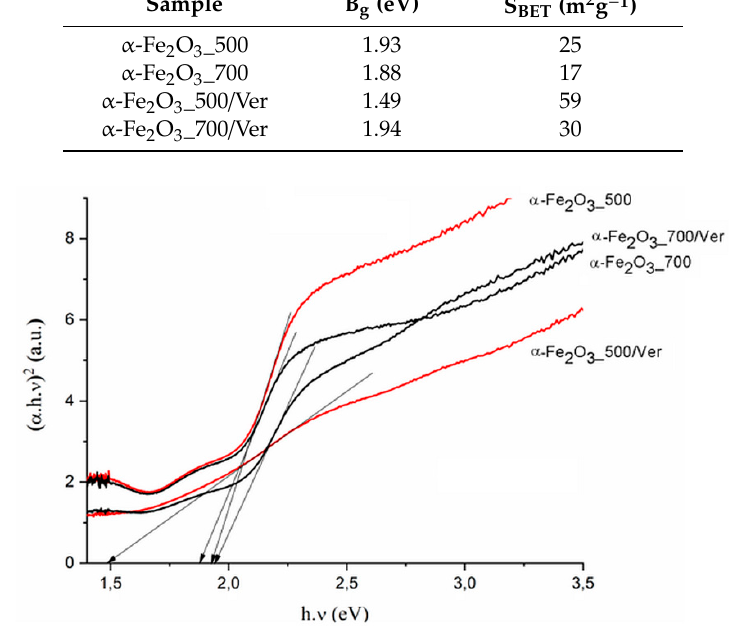
Table 3. Band gap energies (B g ) and specific surface area (S BET ) of the studied samples. Sample